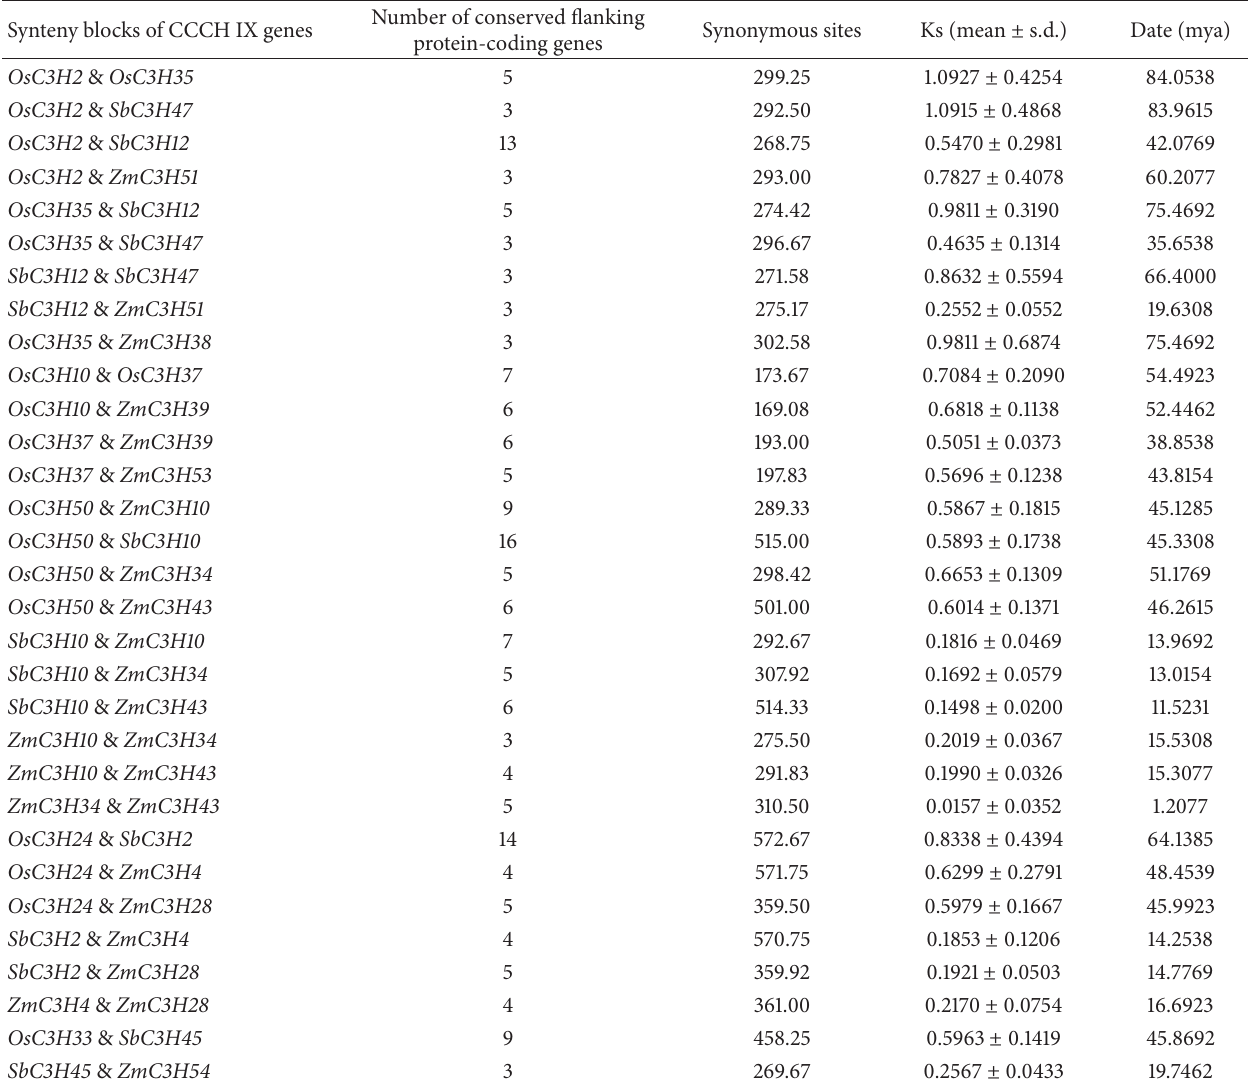
Table 2: Estimation of the dates of large-scale duplication events in three grasses. Synteny blocks of CCCH IX